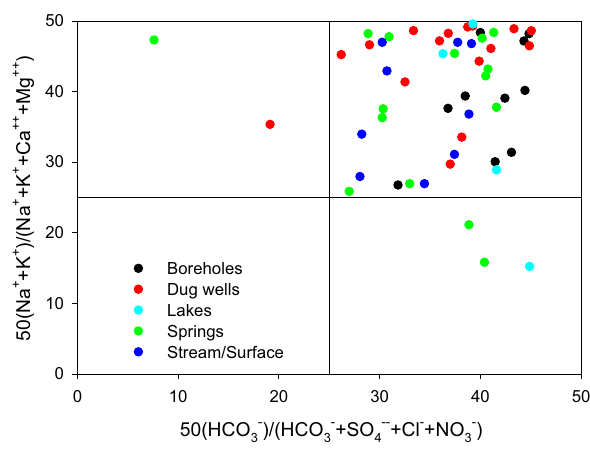
Fig. 17 Compositions of different water types in Meru district (after Langelier and Ludwig 1942)